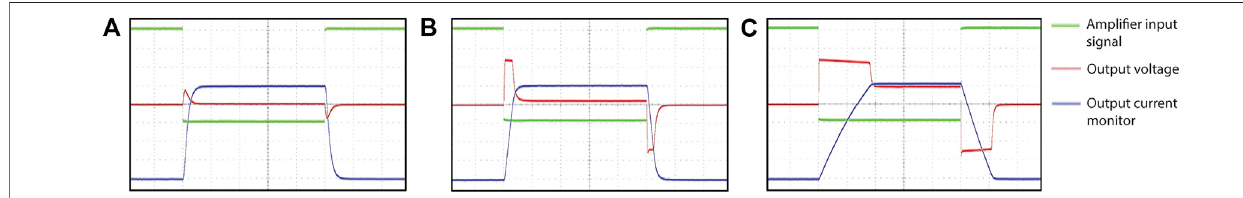
FIGURE 8 | Step response of the ampli fi er as a function of driving current for a gradient coil with resistance 0.32 Ω and inductance 213 μ H. The ramp time is 5 µs and the plateau duration 500 µs. The ampli fi er input signal is shown in green, the output voltage is shown in red, and blue shows the output of the current monitor for a targeted output current of 5 A (A) , 10 A (B) and 15 A (C) . At 15 A the output starts to signi fi cantly limit the slew rate because of clipping to the supply rail.